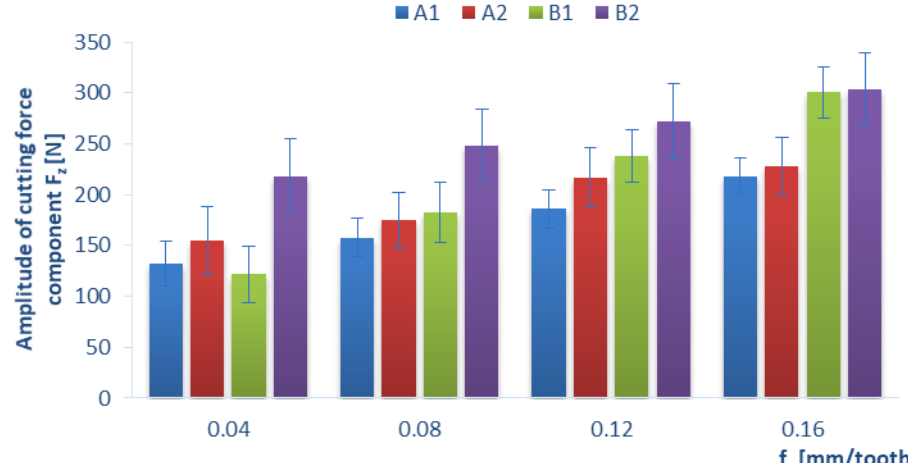
Figure 14. Relationship between the amplitude of the cutting-force component F z and feed per tooth f z in a drilling process conducted with a cutting speed of v c = 182 m/min for different GFRP